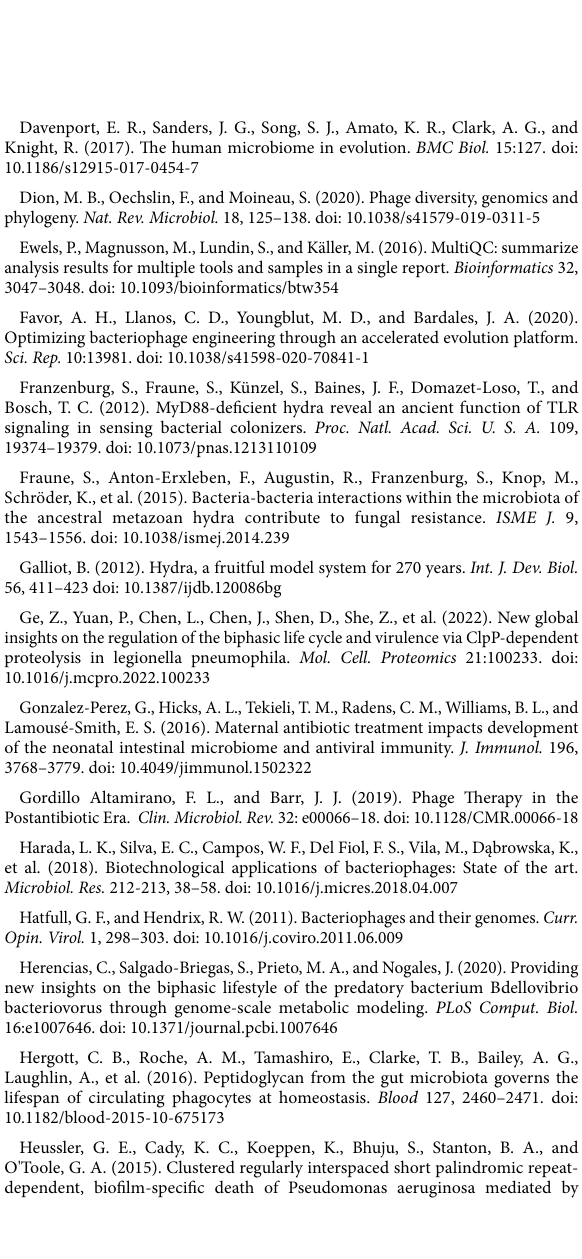
Betaproteobacteria in brown, Firmicutes in purple, Cyanobacteria in red and others in dark gray. SUPPLEMENTARY FIGURE S2 (A) Overlay agar with Curvibacter phage PCA1 spotted on top and mixed into Curvibacter sp. AEP1.3. (B) Growth curves of Curvibacter sp. AEP1.3 with and without Curvibacter phage PCA1 measured at OD600. Magnesium sulfate, magnesium chloride, and calcium chloride were added respectively, (C) Growth curves of Curvibacter sp. AEP1.3 with and without Curvibacter phage PCA1 measured at OD600. Ethyl acetate and 3-oxo-homoserine lactones (3OHC12 and 3OC12) were added, respectively. (D) Top 10 overexpressed and underexpressed proteins in Curvibacter sp. AEP1.3 on Hydra vulgaris AEP, sorted by Z-scores of log 2 fold changes. Top overexpressed and top underexpressed proteins in Curvibacter sp. AEP1.3 on Hydra vulgaris AEP after RNA Seq. according to Z-scores. (E) Growth curves showing Curvibacter sp. AEP1.3 transferred from solid medium to liquid culture, measured at OD 600 . Supernatant from plated Curvibacter sp. AEP1.3 was divided into a small fraction and large fraction before being added to treatments in addition to PCA1